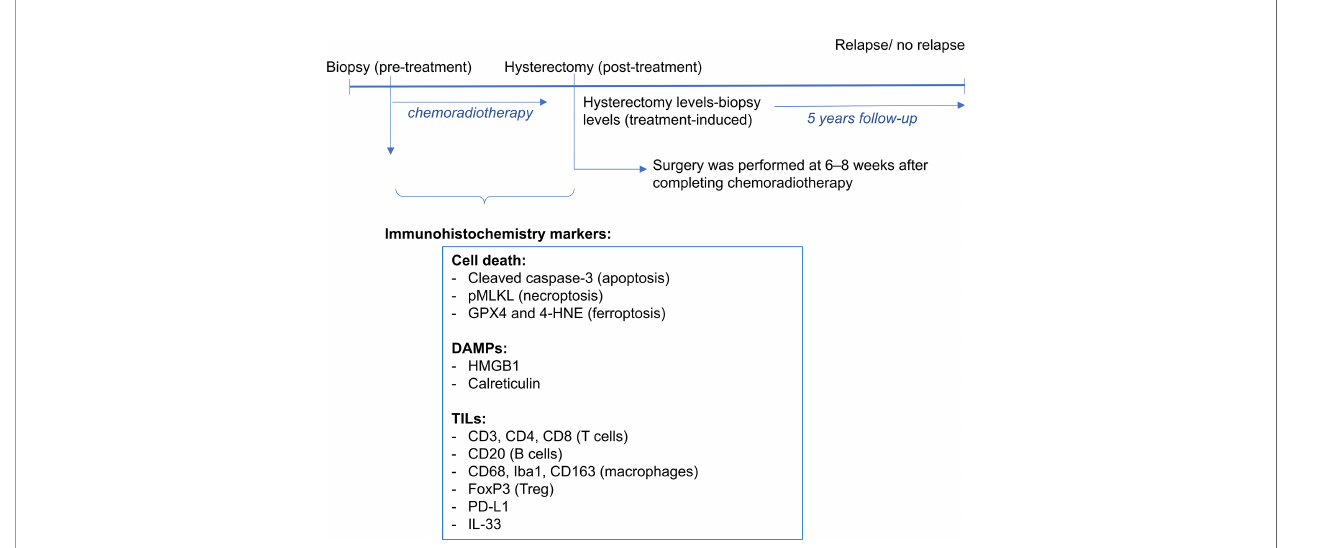
FIGURE 1 | A scheme of the protocol to collect and stain tissue samples is shown. For each patient, a tissue block of the pre-treatment biopsy and post-treatment hysterectomy samples were obtained. Immunohistrochemistry markers were used for cell death and DAMPs (cleaved caspase-3 and pMLKL, GPX4 and 4-HNE, HMGB1 and calreticulin). A previous study assessed the tumor in fi ltrating leucocytes (CD3, CD4, CD8, CD20, CD68, Iba1, CD163, FoxP3, PD-L1 and IL-33). Patients were followed-up up to 5 years post-treatment, period in which survival and relapse were